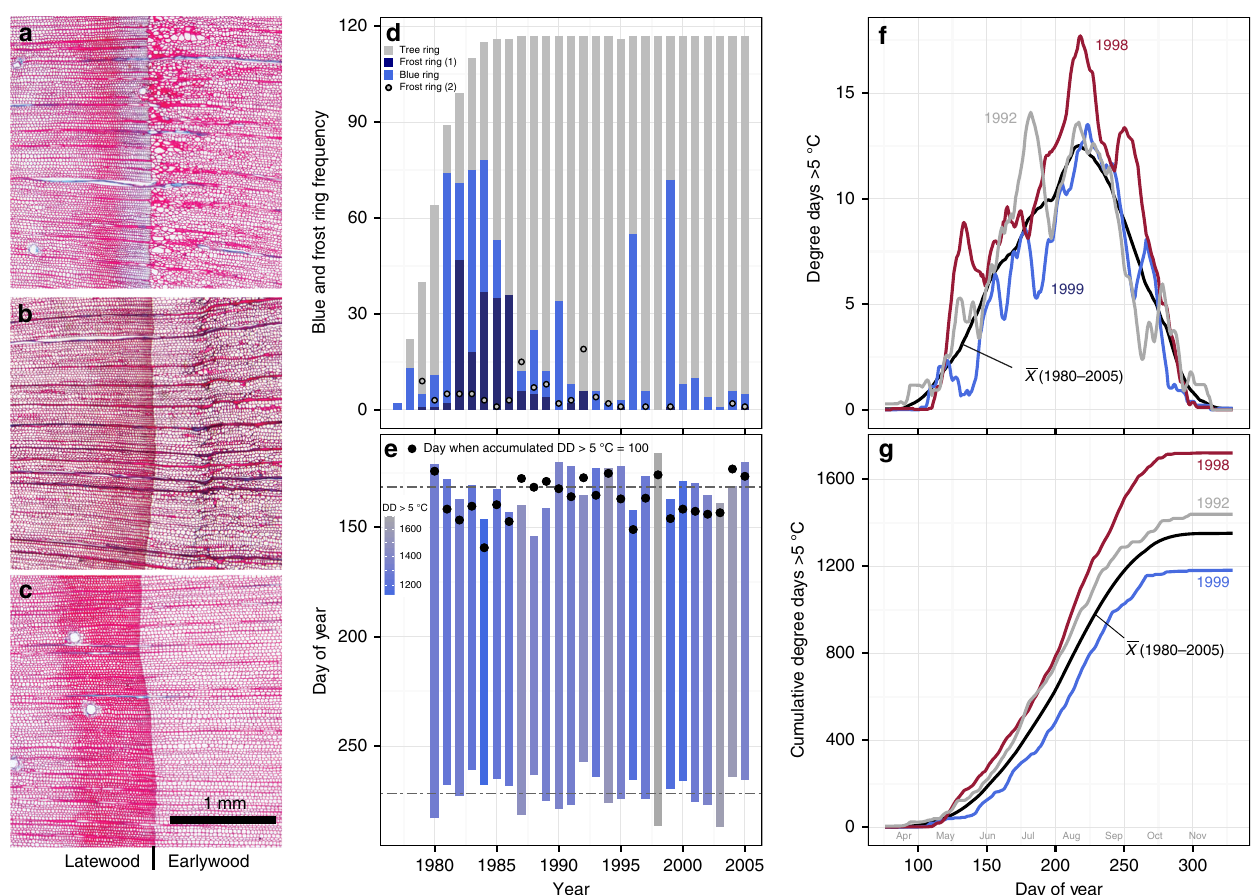
Fig. 1 Blue and frost rings as a function of growing degree days. Stained micro sections of tree rings are shown in a – c . Safranin dyes lignin red and Astrablue dyes cellulose blue, so that the dual-staining procedure results in a blue ring where a layer of cells lacks lignin. a An example for a blue ring of high intensity with a subsequent frost ring in position 1 (i.e., fi rst cells of earlywood indicative of fall frost damage). b A frost ring in position 2 (i.e., later in the earlywood indicative of spring frost damage), while c shows a normal tree ring. d The occurrence of blue and frost rings by year. Gray bars indicate the sample size per year (total n = 2999), light blue bars indicate the occurrence of blue rings, dark blue bars represent frost rings occurring in position 1, and the gray points represent frost rings in position 2. e Bars represent growing season de fi ned as frost free days, black circles represent early warming in spring, as the date on which cumulative degree days above 5 °C exceeded 100. Horizontal dashed lines indicate the average start and end of the growing seasons. f Examples of growing degree days above 5 °C among for a year with high occurrence of blue rings (1999), a year with frost rings in position 2 (1992), a year with no blue or frost rings (1998), as well as the overall average (1980 – 2005). The lines are smoothed using a 15-day running mean. g The cumulative effect of